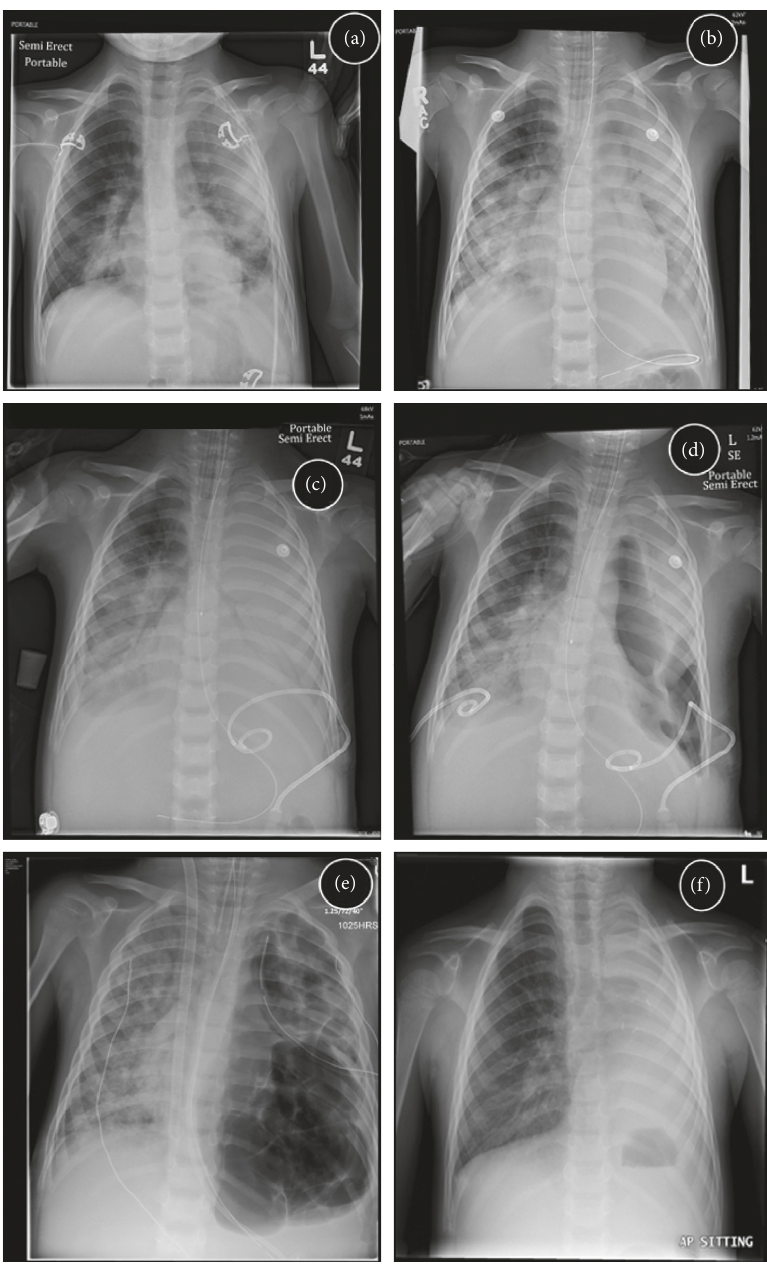
Figure 1: Chest radiographs showing progression of disease. (a) Presentation to ED. (b) Presentation to PICU. (c) Left hemithorax white- out, with percutaneous chest tube. (d) Right pleural effusion following drainage with the percutaneous chest tube. (e) Extensive pneu- matocele development prior to pneumonectomy. (f) Resolution of acute disease, following removal of noninvasive respiratory